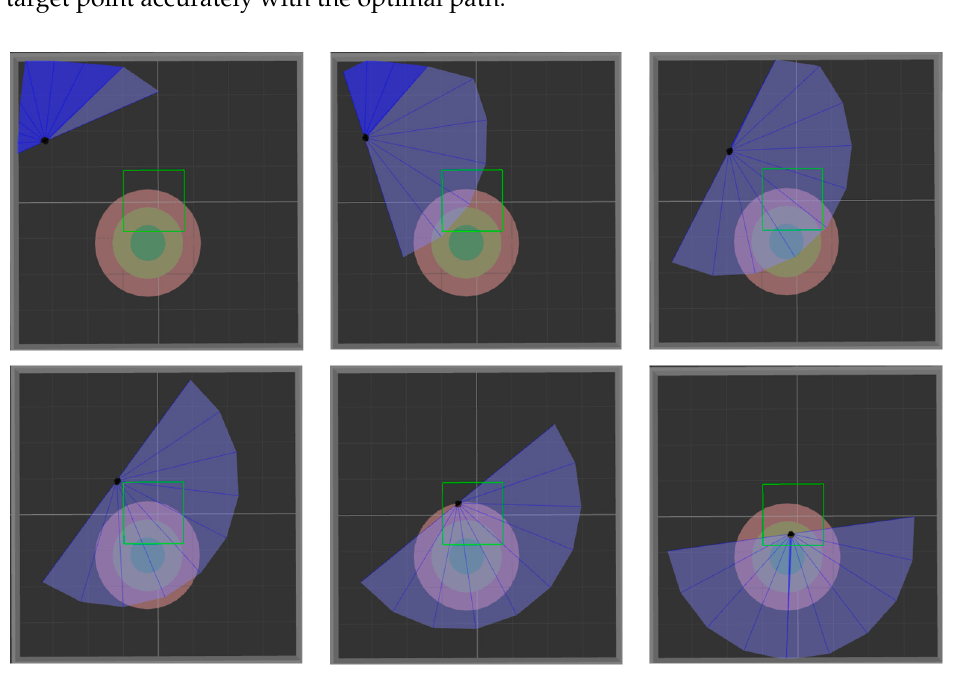
Figure 10. The movement process of mobile robot in simulation Figure 6c. Tables 2 and 3 record the test results in simulation Figure 6a and simulation Figure 6c, respectively. It can be seen from Table 2 that the path planning success rate of the algorithm proposed in [31] is only 86%, while the success rate of the MN-LSTM-DDPG algorithm proposed in this paper can reach 100%. In terms of time, compared with the algorithm proposed in [31], the path planning time of the MN-LSTM-DDPG algorithm proposed in this paper is shortened by 21.48%. However, when the model trained in sim- ulation Figure 6a is applied to simulation Figure 6c, the testing effect of each algorithm is not ideal, as shown in Table 3. Therefore, it is necessary to train the algorithm in an envi- ronment with obstacles.